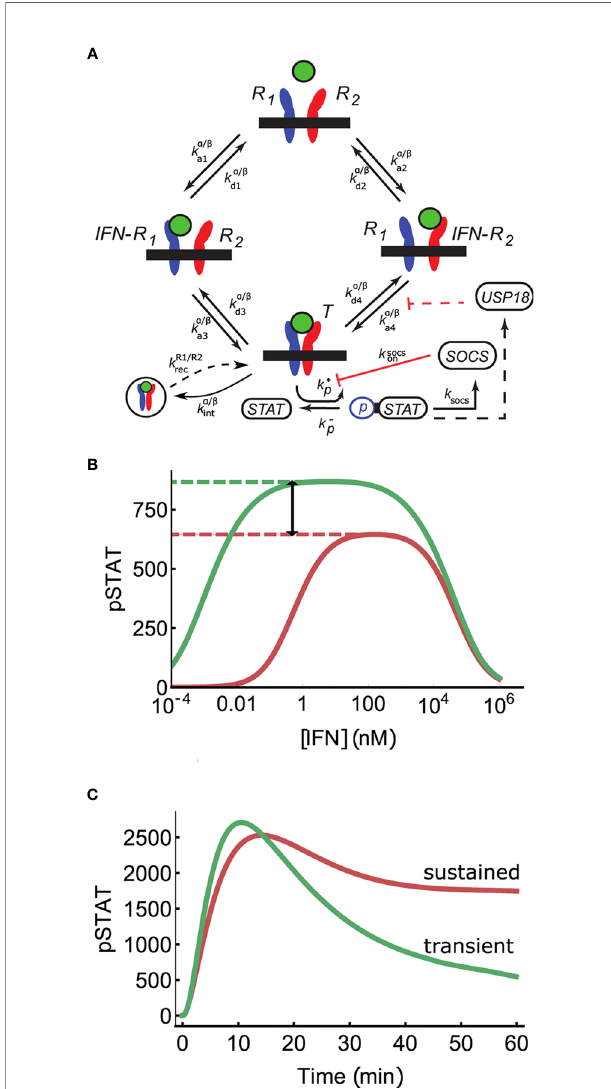
FIGURE 1 | Mechanisms of signal discrimination. (A) Interferon induced receptor dimerization can occur via two paths. In the fi rst, an IFN molecule (green circle) binds IFNAR1 (R 1 in the diagram), and IFNAR2 subsequently associates with the binary IFN-R1 complex, leading to the formation of the ternary complex T. In the second pathway, the sequence of the association events is reversed. The multi-step process of STAT phosphorylation is combined into an aggregate rate k p , as are all steps leading to SOCS1 production in rate k socs . SOCS1 binds to IFNAR1 independent of whether or not IFNAR1 is bound by IFN, and inhibits phosphorylation of STAT, with rate k socs on . USP18 is modeled as pre-bound to IFNAR2 (i.e., before IFN stimulation) and reduces IFNAR1 recruitment into the ternary complex by increasing k -4 (see Long Time Deactivation via USP18 Regulates Receptor Complex Stability to Achieve Absolute Discrimination ). (B) Absolute discrimination encodes signal identity through differences in the maximum response amplitude for weaker binding IFN a 2 (red) compared to stronger binding IFN b (green) even for saturating doses ([IFN] > K eff ). Thus, if the pSTAT response is greater than this threshold (red dashed line) the signal is unambiguously identi fi ed as belonging to IFN b . The region of absolute discrimination is indicated by black arrow. (C) Time course discrimination differentiates ligands based on, for example, sustained (red, IFN a 2) versus transient (green, IFN b ) pSTAT